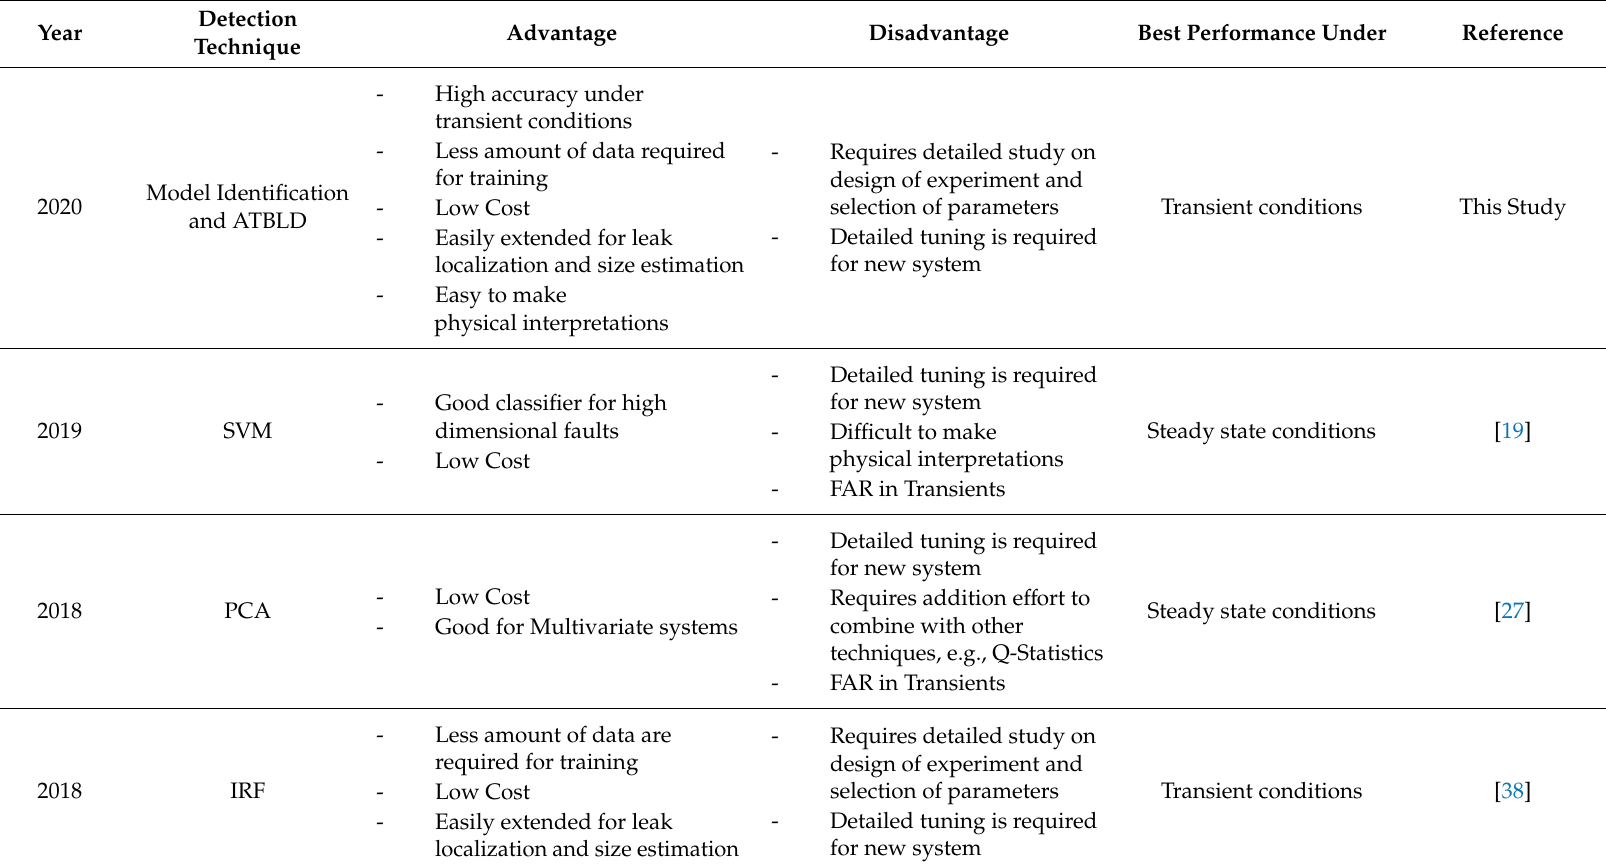
Table 9. Comparison between our work and recent leak detection